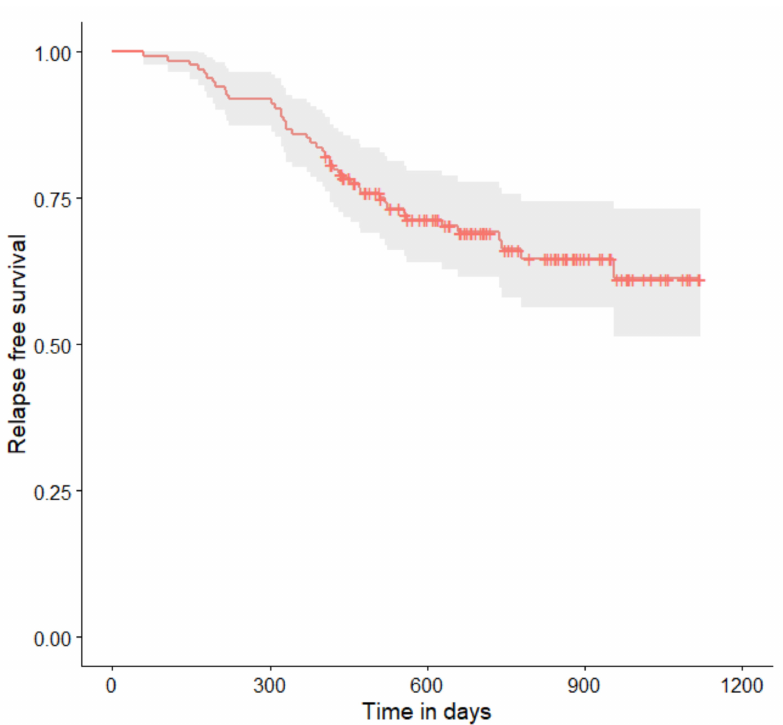
Figure 4. Relapse-free survival curve with 95% CI (darkened area) for all patients.